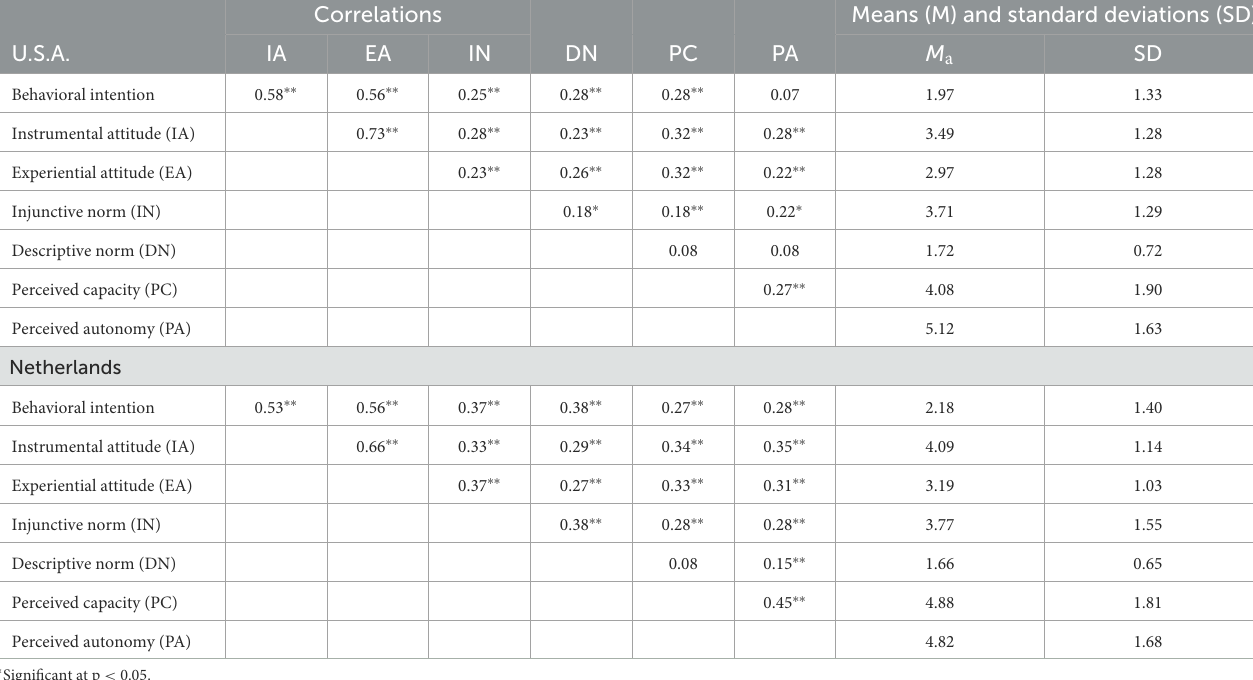
TABLE 4 Descriptive statistics: correlations, means, and standard deviations for having a vegetarian diet U.S.A. and Netherlands.